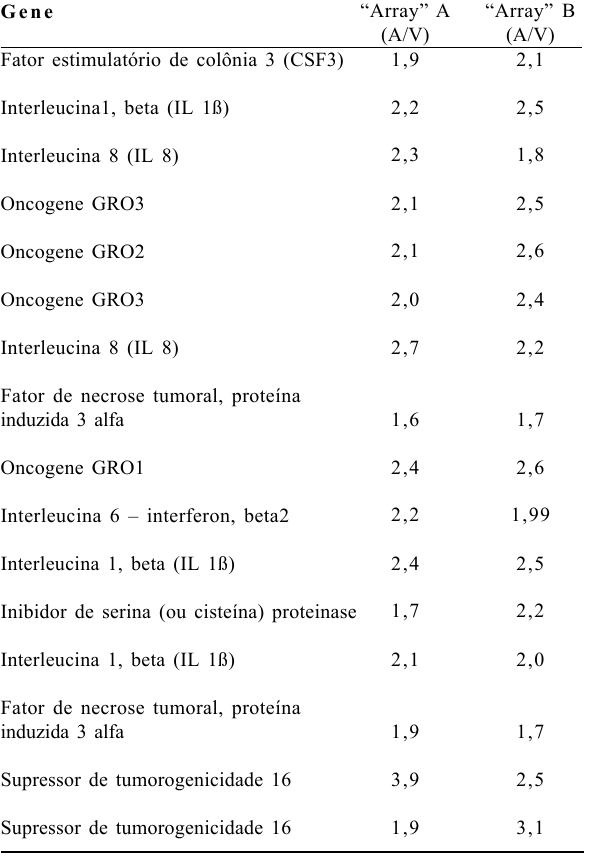
Tabela 1. Genes selecionados em experimento de “cDNA microarray” realizado em veia safena cultivada em regime hemodinâmico venoso (fluxo: 5 ml/min) e arterial (fluxo:50 ml/min, pressão: 80 mmHg) por 1 dia. A lâmina utilizada